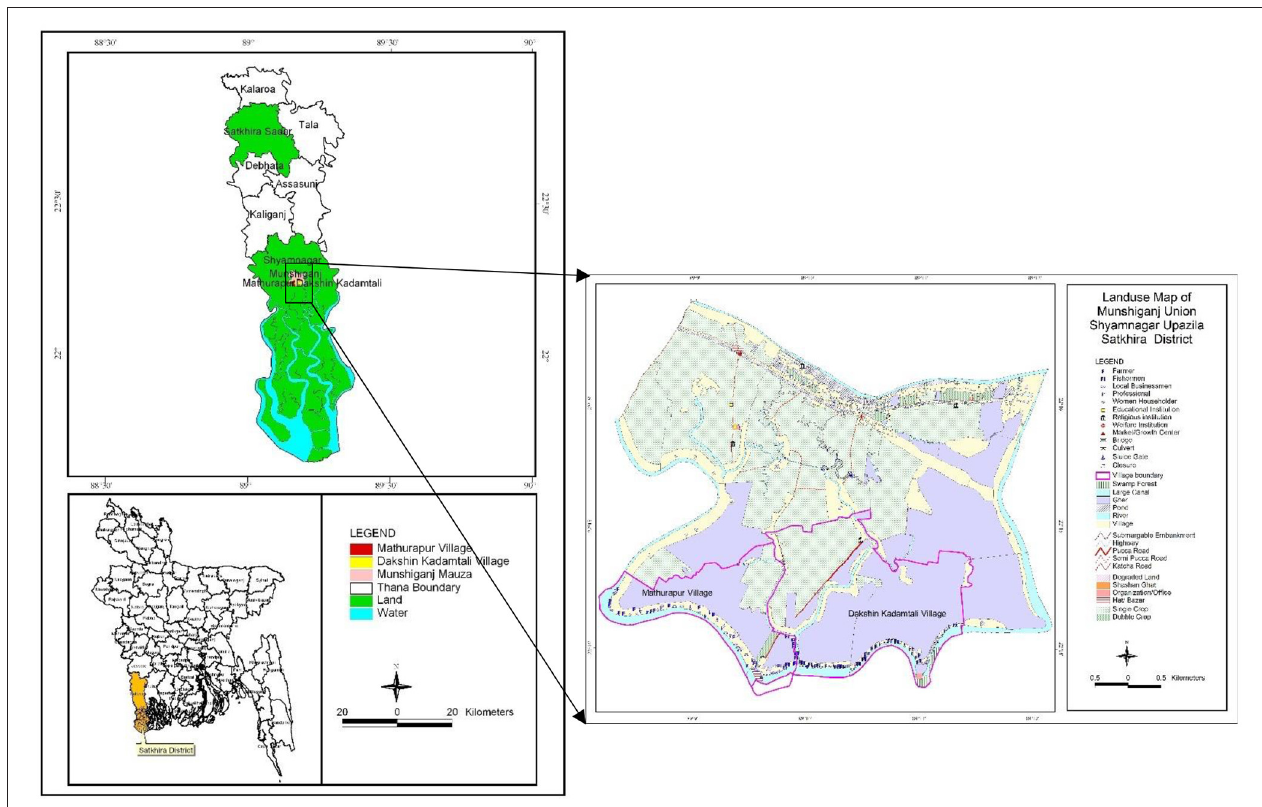
FIGURE 2 | Satkhira District of Bangladesh (left) ; Land use map of of Munshigang Union of Satkhira District with the sampling points (location of interviewees) of Mathurapur Village and Dakshin Kadamtali Village (right) . Created by authors using